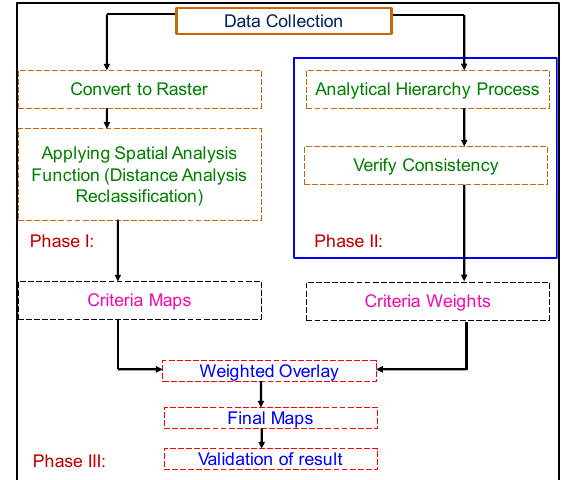
Fig 2: Flowchart for integrating spatial analysis with Analytical Hierarchy Process (AHP) (Satty in